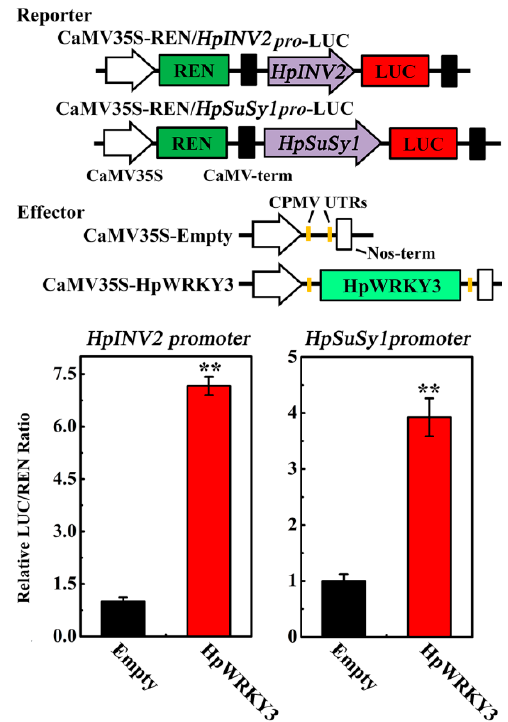
Figure 6. HpWRKY3 activates HpINV2 or HpSuSy1 transcriptions by dual-luciferase transient expression assay in Nicotiana benthamiana leaves. The reporter and effector vectors are illustrated in the top panel. Data are means ± S.E. of six independent biological replicates. Asterisks indicate significant differences by student’s t- test (** p < 0.01).